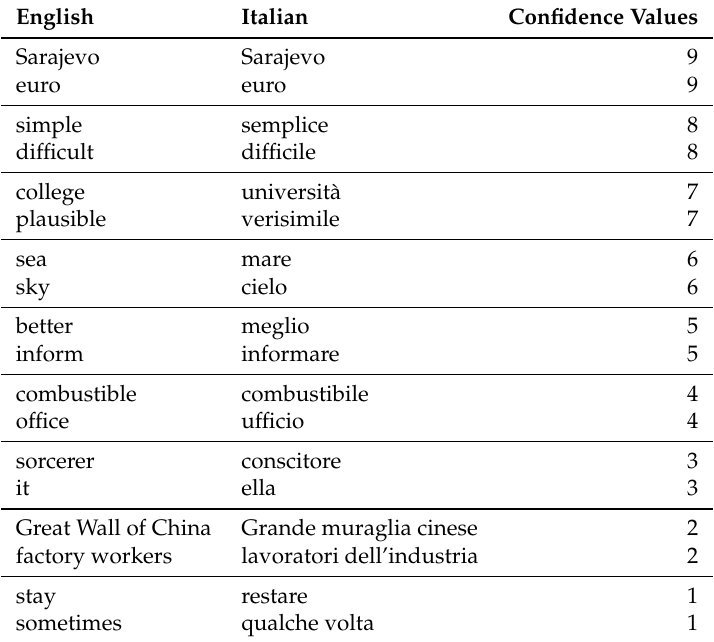
Table 2. Sample of PanLex entries of the extracted tsv